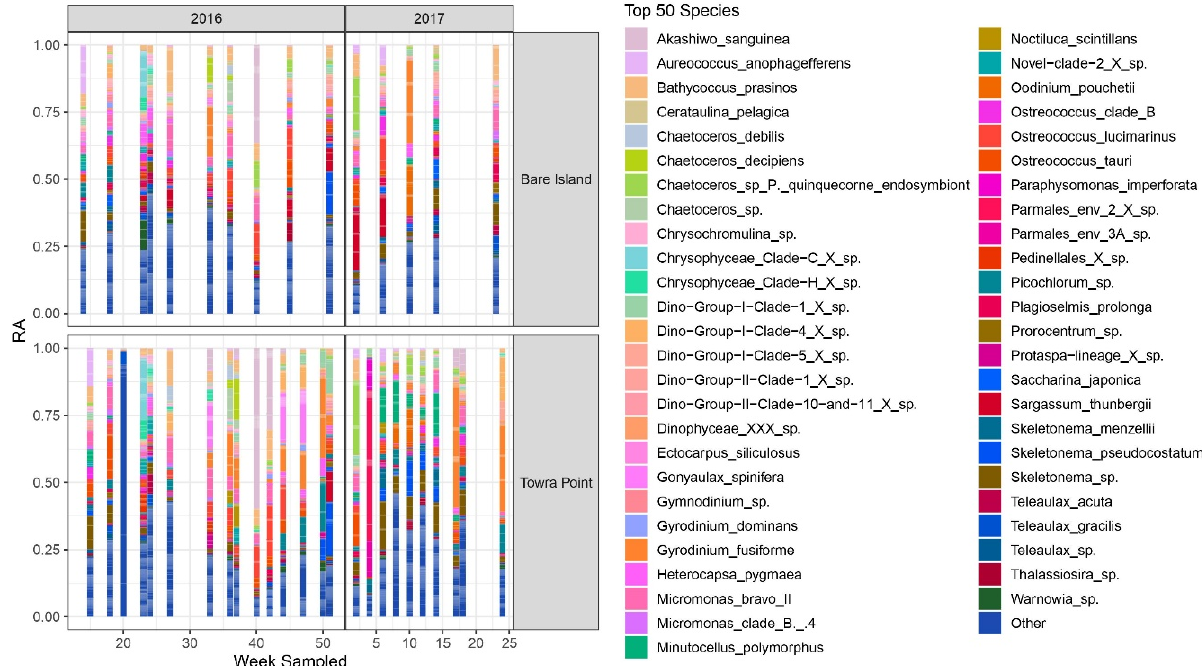
Figure 5. Relative abundance of the top 50 phytoplankton spp. at the Bare Island and Towra Point time series stations from April 2016 to June 2017. ASVs were assigned to phytoplankton species in the PR2.12 database. For clarity, only the top 50 by ASV abundance are shown. The less abundant taxa were lumped into the category “Other,” while those without taxa assignments to the genus level were omitted.